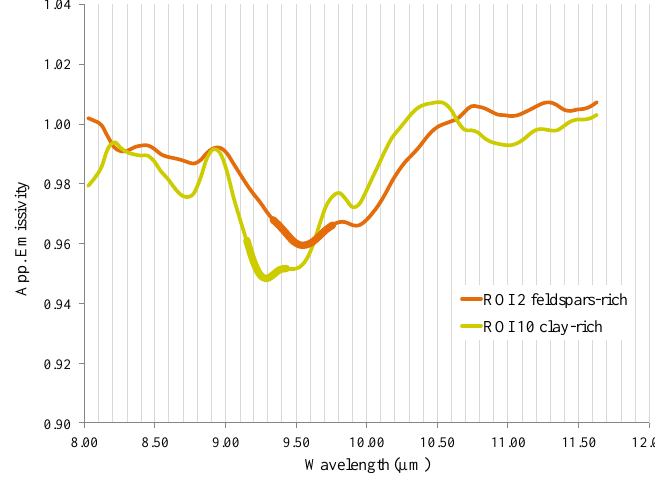
Figure 10. ( a ) Ls/Lb spectra and ( b ) approximate emissivity spectrum of ROI 4. The relevant features are emphasized with thick lines for the identified minerals.